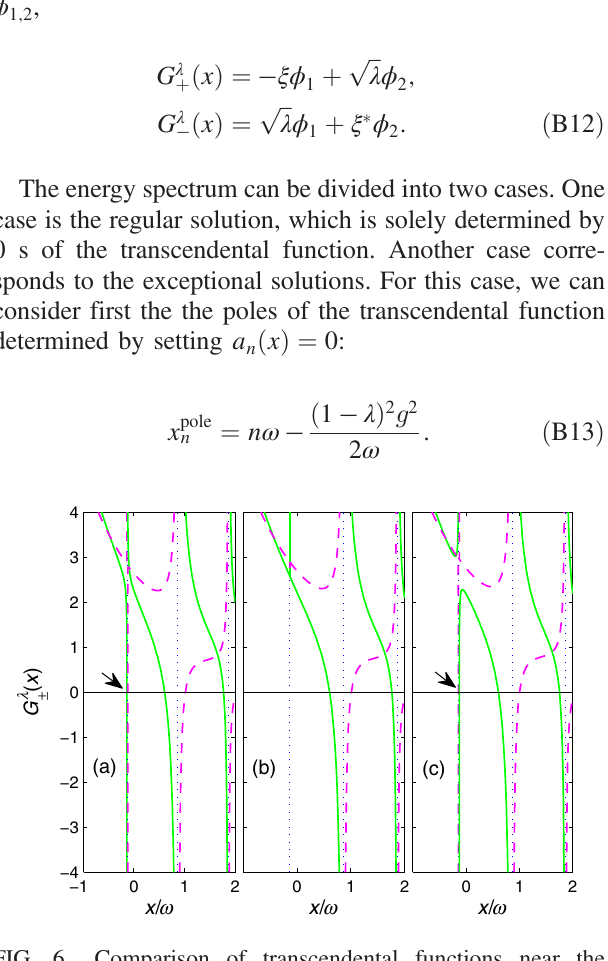
FIG. 6. Comparison of transcendental functions near the ground-state degenerate point. From left to right, the parameters − 0 . 01 , (b) g ¼ g 0 . 01 , where are (a) g ¼ g , and (c) g ¼ g ffiffiffiffiffi p c c c þ 4 = 15 g , which is the degenerate point. G λ ð x Þ (solid green c ¼ þ line) and G λ − ð x Þ (dashed purple line) are presented as functions of x , where ω ¼ 1 , Δ ¼ 0 . 4 , λ ¼ 0 . 5 , and θ ¼ 0 . The differences between (a) – (c) can be observed, for example, at the points marked by arrows in the figures. For (a), at the point marked by an arrow, the energy of positive parity is slightly less than the energy of negative parity; it is reversed in (c), while in (b), the pole is lifted since K 1 ¼ 0